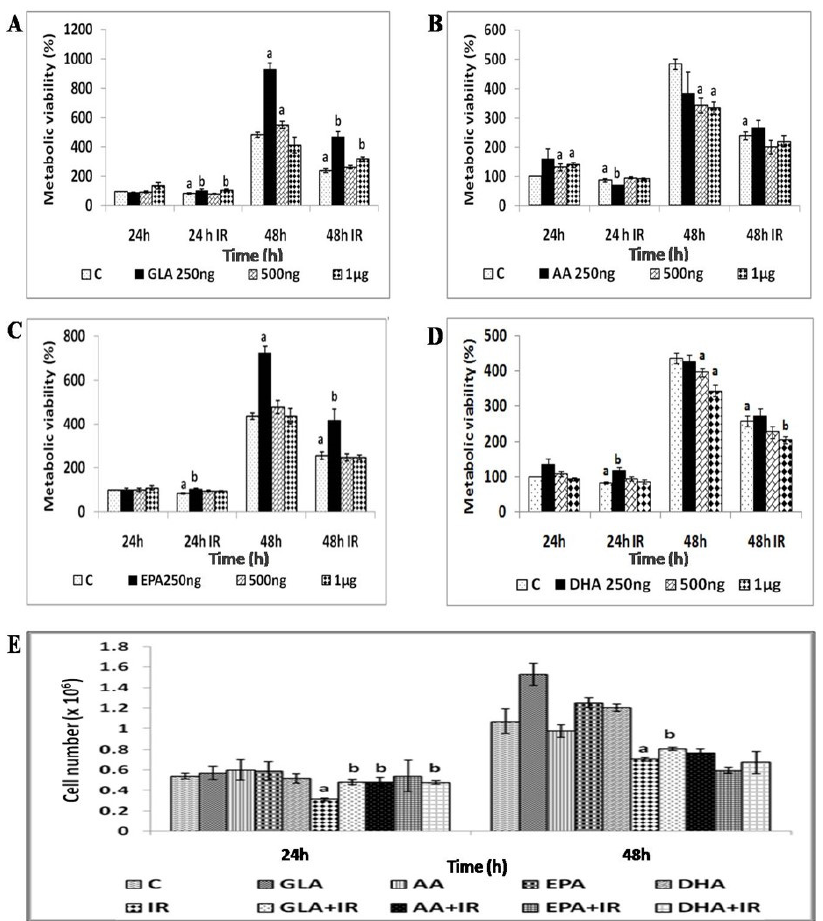
Figure 3. Effect of various doses of different PUFAs on radiation-induced cytotoxic action on RAW 264.7 cells in vitro at 24 and 48 h post-radiation, as assessed by MTT assay. Doses of PUFAs used were 250 ng/mL, 500 ng/mL, and 1 μ g/mL). ( A ) = GLA; ( B ) = AA; ( C ) = EPA; and ( D ) = DHA; ( E ) = Effect of various PUFAs (GLA, AA, EPA, and DHA) on the growth kinetics of RAW 264.7 cells following irradiation. All values (n = 6) are expressed as mean ± SEM. Significance ( p < 0.05) repre- sented by a , b when compared with control and irradiation, respectively. C, control; GLA, gamma- linolenic acid; AA, arachidonic acid; EPA, eicosapentaenoic acid; DHA, docosahexaenoic acid; IR, irradiation (2 Gy).